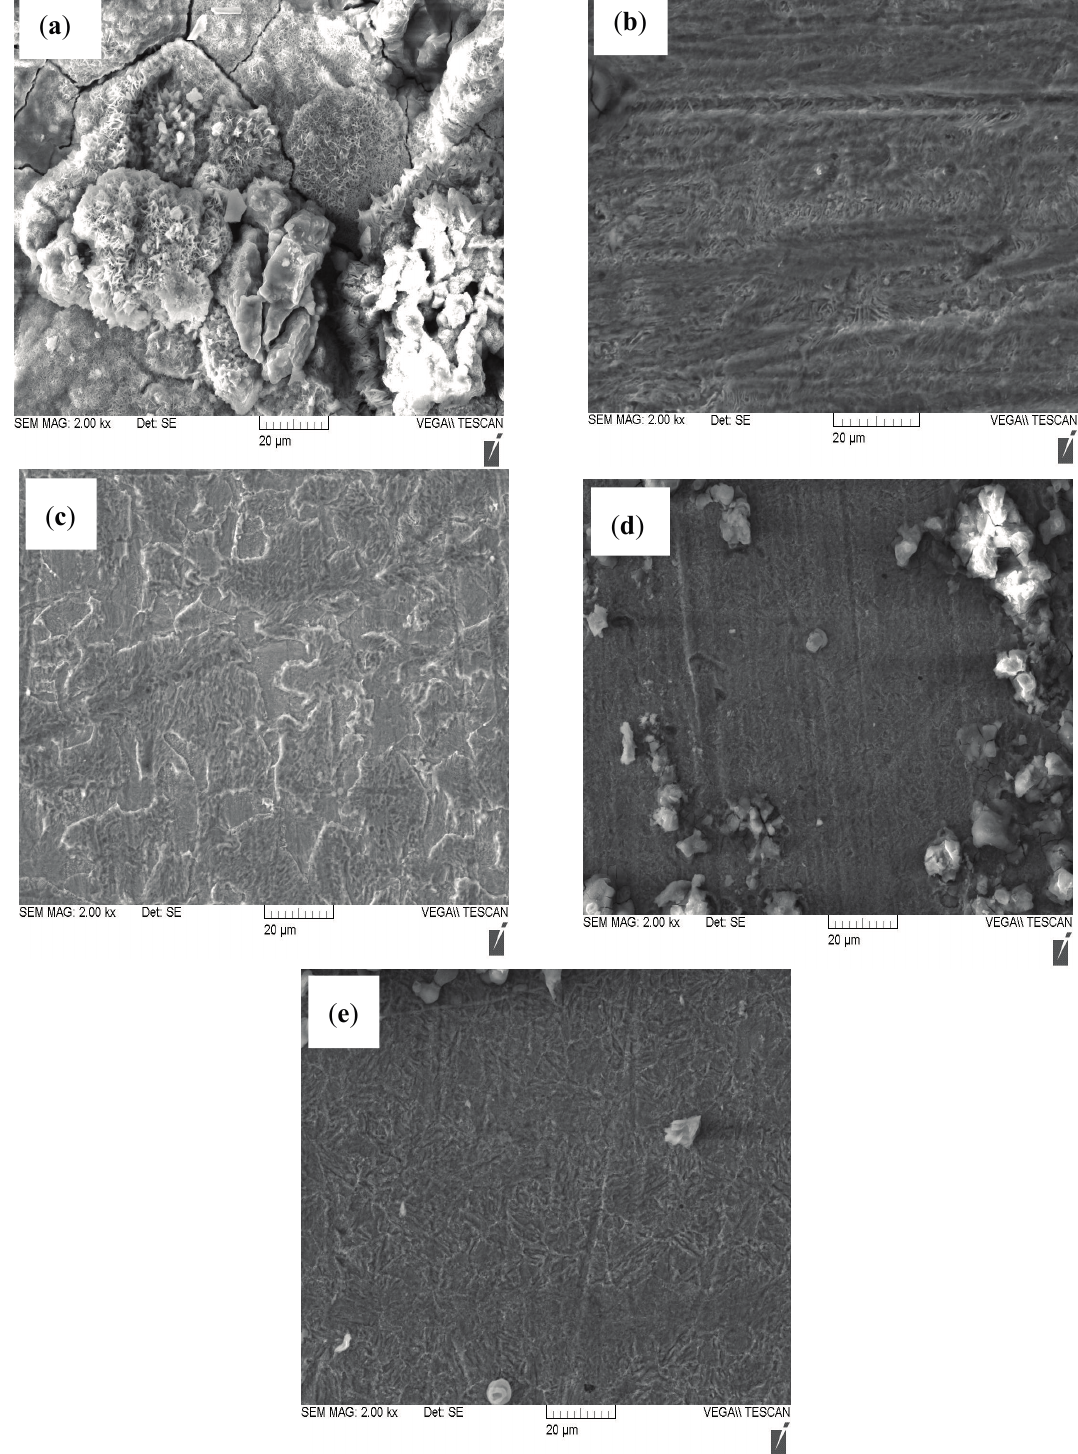
Figure 8. SEM images of N80 steel in 3.5% NaCl saturated with CO 2 ( a ) without the inhibitors; and with 200 ppm ( b ) HPTB; ( c ) T4PP; ( d ) THP and ( e )